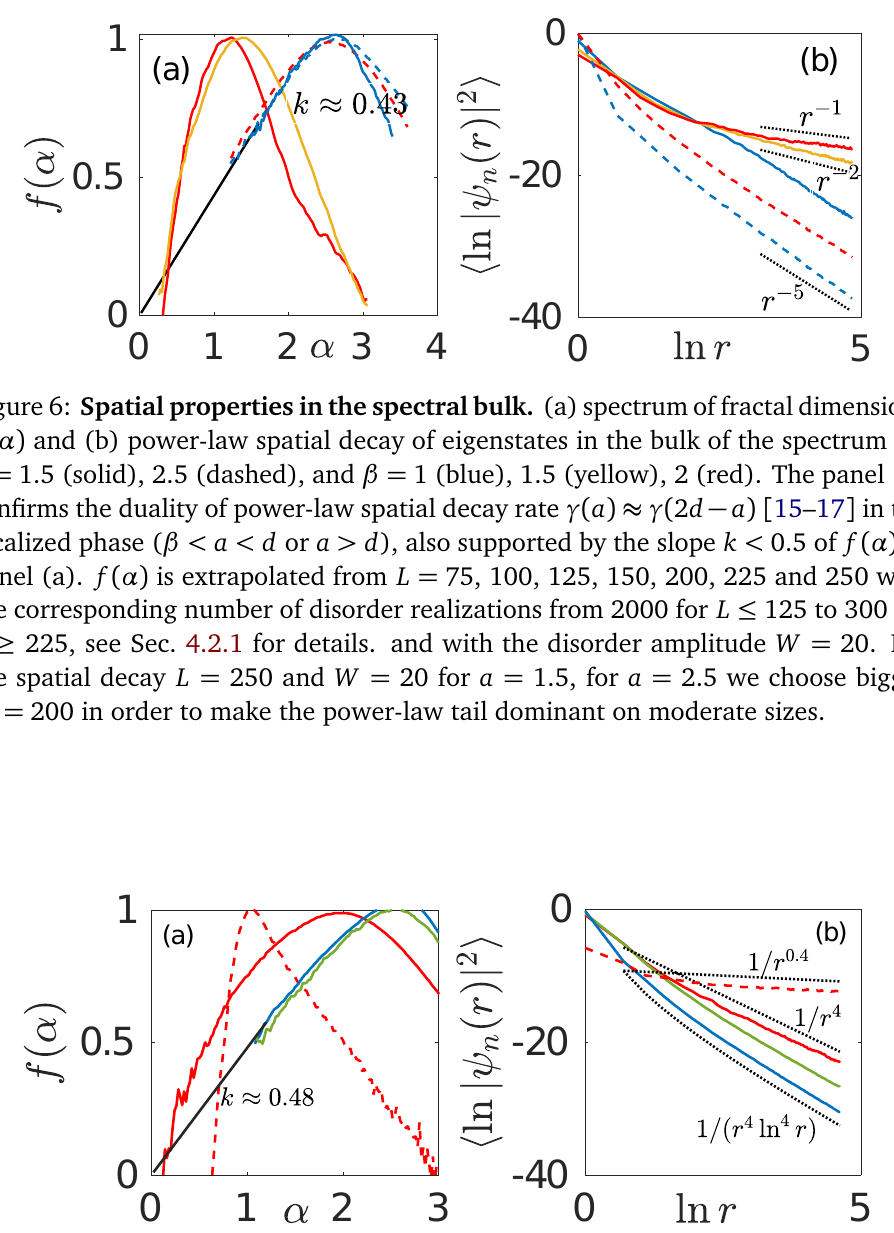
Figure 7: Spatial properties at the dual line a = d = 2 . (a) spectrum of fractal dimensions f ( α ) and (b) power-law spatial decay of eigenstates in the bulk of the spectrum at the self-dual line a = 2 of (14) for β = 1 (blue), 2 (red), 3 (green). The linear behavior of f ( α ) with the slope close to k = 0.5 supports the critical localiza- tion for β (cid:54) = 2. The exceptional point a = β = 2 shows the transition from ergodicity ( W = 4, dashed) to localization ( W = 40, solid) over the disorder amplitude. The disorder strength for β = 1, 3 is W = 40. f ( α ) is extrapolated from L = 75, 100, 125, 150, 200, 225 and 250 with the corresponding number of disorder realizations from 2000 for L ≤ 125 to 100 for L = 250, see Sec. 4.2.1 for details. For the spatial decay L =